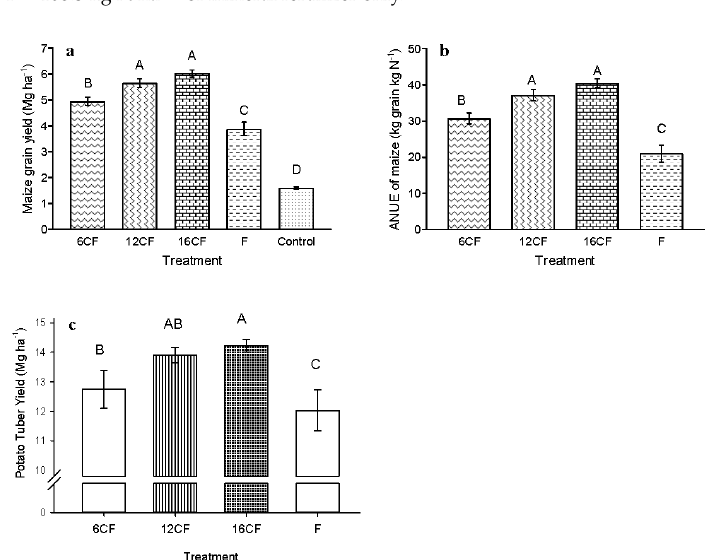
Figure 2. ( a ) Maize grain yield (MGY, dry weight), ( b ) agronomic nitrogen use efficiency (ANUE) of maize, and ( c ) potato tuber yield (PTY, fresh weight) in the different treatments of the study,. 6CF = 5.7 Mg ha -1 compost on fresh weight (FW) basis and 72.8 kg N ha -1 mineral fertilizer; 12CF = 12 Mg ha -1 compost (FW) and 39.4 kg N ha -1 mineral fertilizer; 16CF = 16 Mg ha -1 compost (FW) and 19.5 kg N ha -1 mineral fertilizer; F = 108.3 kg N ha -1 mineral fertilizer only; Control = no input. Different letters above columns indicate significant differences between treatments ( p < 0.05).